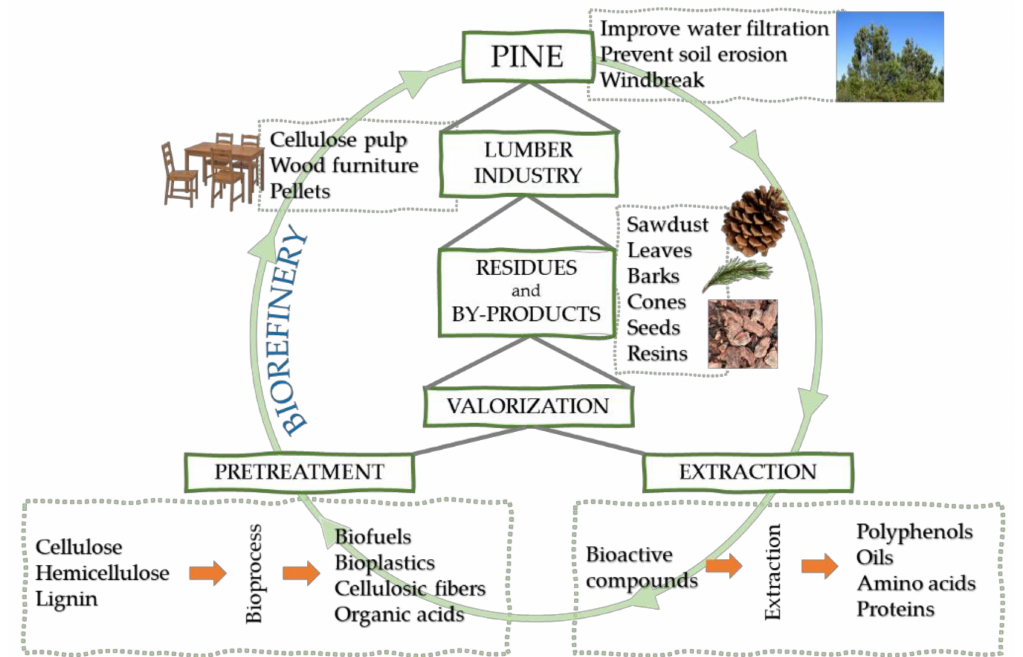
Figure 1. Pine valorization under biorefinery